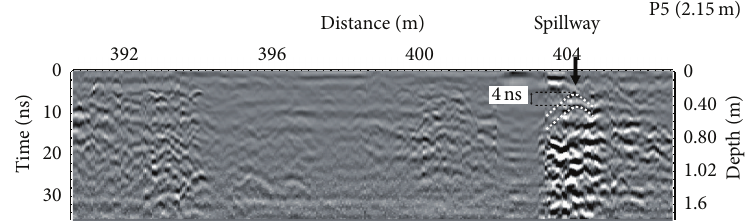
Figure 11: Profile P5 (200 MHz) on the paved revetment showing the hyperbolae directly above a spillway.